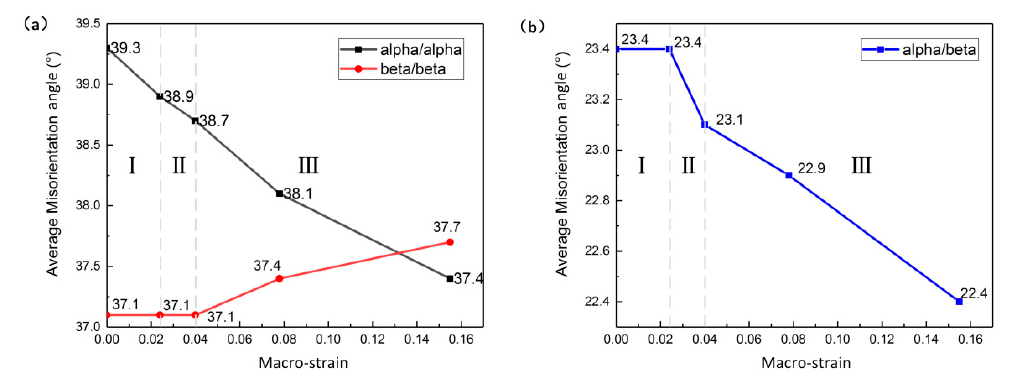
Figure 14. Average misorientation angle-macro strain curve for ( a ) α / α and β / β and ( b ) α / β phases.